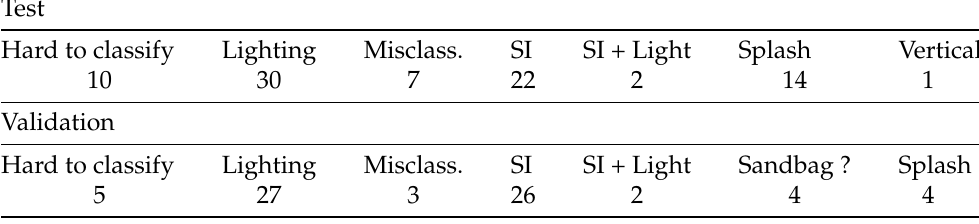
Table A6. Errors explanation for Zarautz data. “Misclass.” stands for misclassification during annotation, “Splash” corresponds to an intermediate storm regime between impact and overwash, “Vertical” corresponds to the presences of vertical features of runup. Finally, “SI” corresponds to an intermediate storm regime between swash and impact that was very close to the sea wall but did not